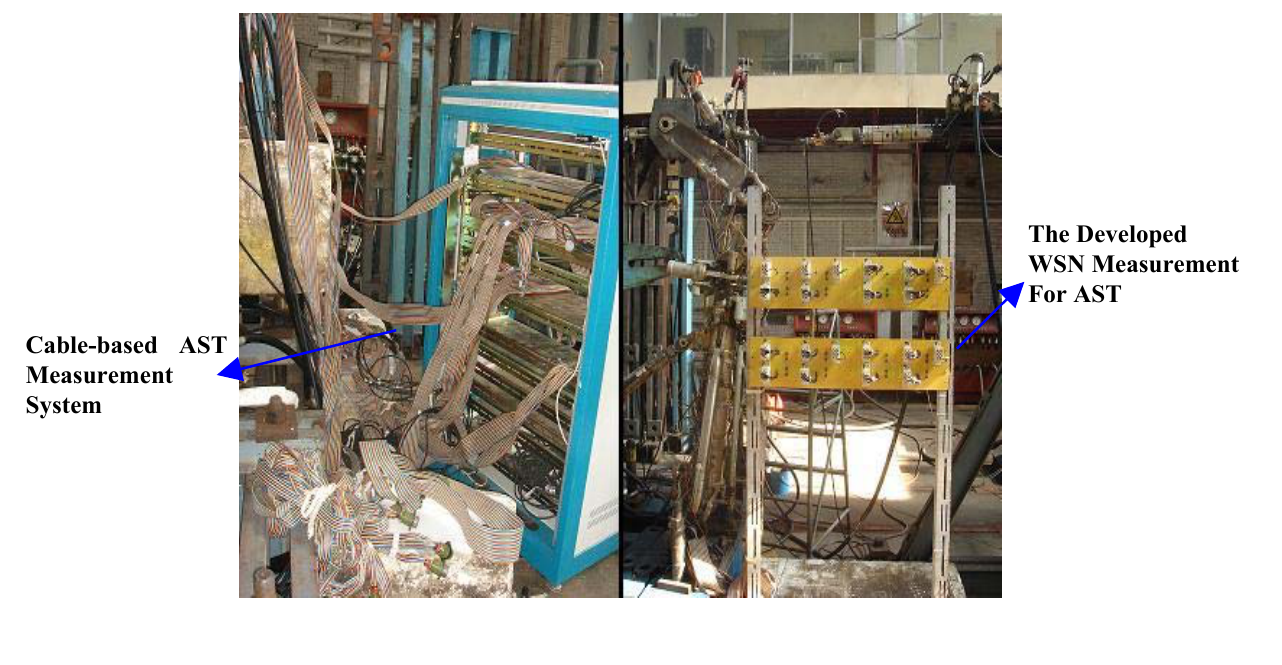
Figure 15. Setup comparison between WSN and the cable-based system for